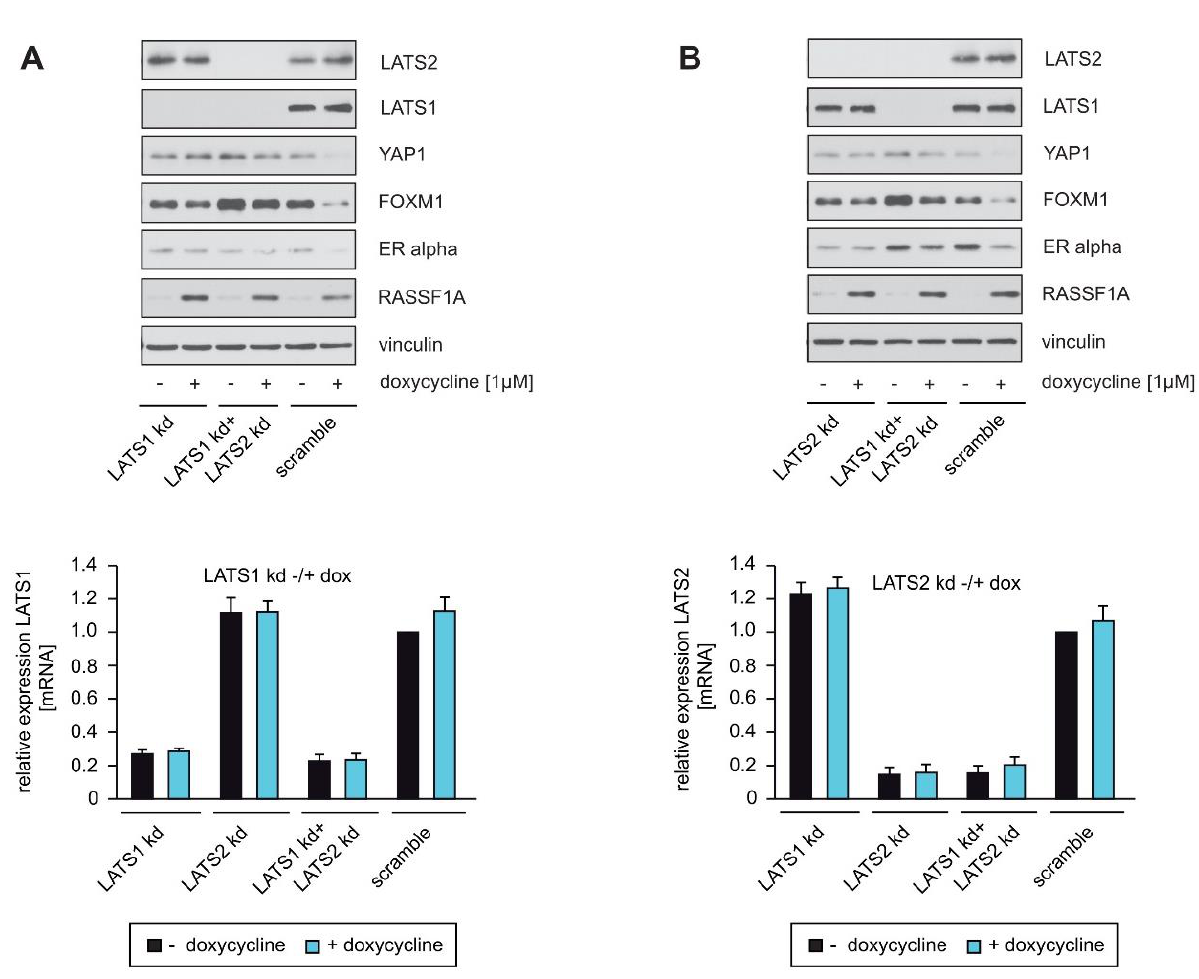
Figure 4. LATS1 and LATS2 knockdown circumvent RASSF1A-mediated suppression of YAP1, ER α and FOXM1 expression. ( A , B ) Stable knockdown of LATS1, LATS2 and LATS1+LATS2 was performed in MCF7 conditionally expressing RASSF1A cells using shRNAs (LATS1 kd and LATS2 kd). For Western blotting, SA- β -gal staining, colony-forming assays and qPCR analysis, equal numbers of conditional MCF7 cells were plated on either 10 cm cell culture or six-well plates and transduced with equal amounts of lentiviral particles carrying non-targeted shRNA (scramble), shRNA LATS1 kd or shRNA LATS2 kd lentiviral particles. Then, 48 h after transduction, conditional RASSF1A MCF7 cells were cultured in the absence or presence of 1 μ g/mL doxycycline. Cell lysates and mRNA were prepared 48 h after doxycycline treatment. Western blots of lysates from the conditional RASSF1A MCF7 scramble, LATS1 kd, LATS2 kd and LATS1+LATS2 double knockdown (LATS1 kd+LATS2 kd) cells were probed with the indicated antibodies (left panels). Efficiency of LATS1, LATS2 and LATS1+LATS2 double knockdowns were also quantified by qPCR. Mean values ± s.d. of two independent experiments are presented.